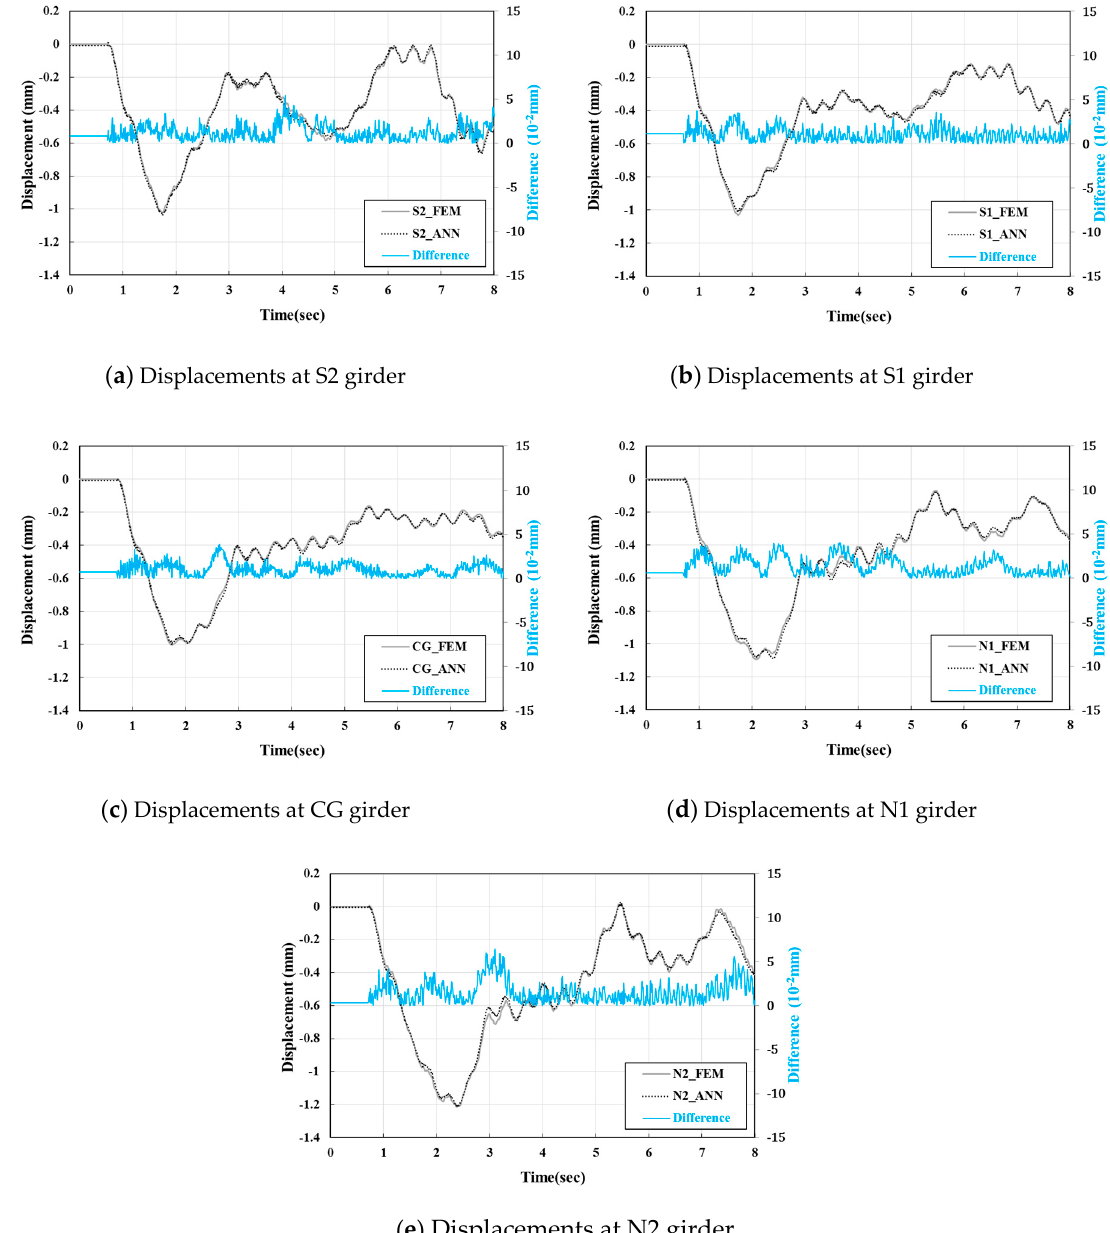
Figure 11. Test results at midpoint of girder for 40 km/h.